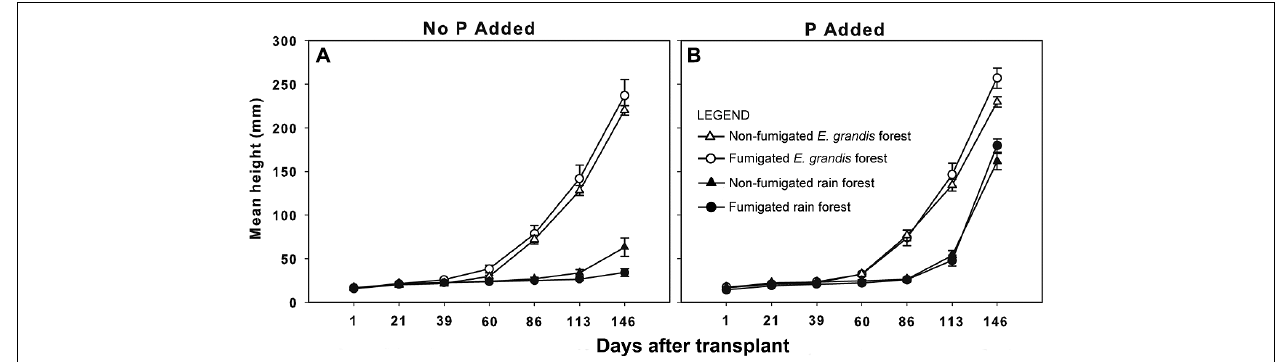
FIGURE 4 | Mean height (mm ± SE) of Eucalyptus grandis seedlings grown with no phosphorus (P) added (A) or with phosphorus added (B) versus days after transplant (DAT). P addition began 86 DAT. The numbers of surviving replicates at 146 DAT were: non-fumigated E. grandis